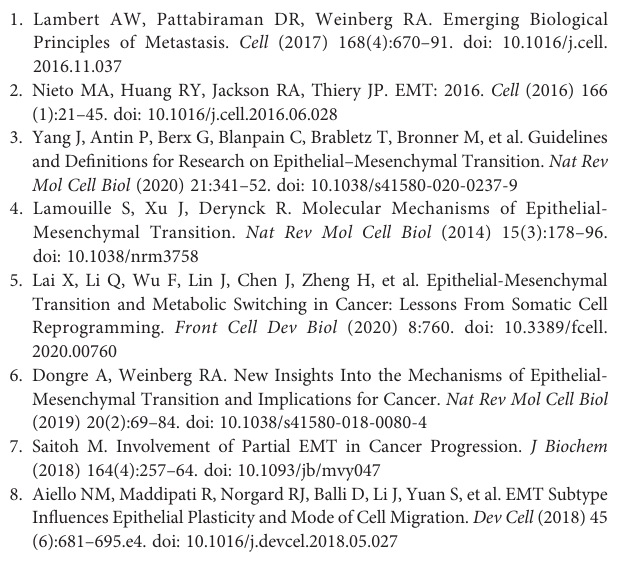
Supplementary Figure 3 | Invasion and EMT studies.These studies were done the same way as described for . (A) Invasion rate study in A549 cells. (B) Invasion rate study in H1299 cells. (C) Quanti fi cation of the western blot analysis. Supplementary Figure 4 | Quanti fi cation of fi lopodia induced by either eATP or TGF- b at different induction times. A549 and H1299 human NSCLC cells were treated by either eATP or TGF- b for 2, 6, and 12 hours. The formation of fi lopodia were photographed by fl uorescence microscopy and counted from >10 randomly chosen views for each condition (average 100-200 cells per condition). Filopodia growingonthecellswerearbitrarilycategorizedasnone,early,mid,andlatestages, based on their size, shape and number, and were separately counted by four individuals and then averaged. (A) A549 cells. (B) H1299 cells. These results indicate that eATP induced time-dependent fi lopodia formation similarly to TGF- b . Supplementary Figure 5 | Intracellular ATP measurement study. This study was done the same way as described for but on H1299 cells. (A) iATP levels of H1299 cells treated with different concentrations of eATP. (B) iATP levels of H1299 cells treated with different concentrations of TGF- b . Untreated cells were used as